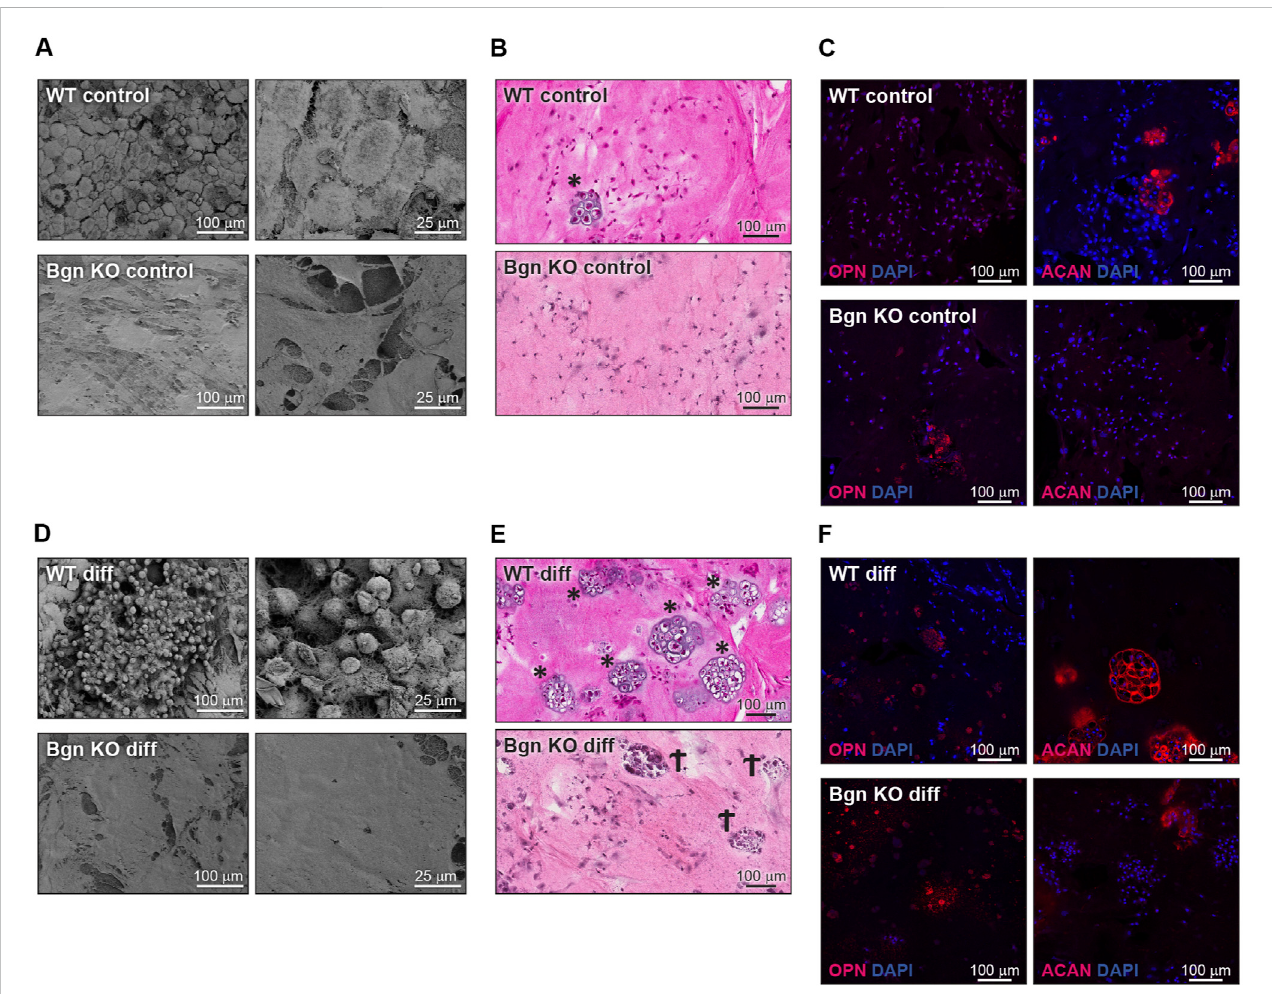
FIGURE 5 Bgn affects cartilage and bone differentiation in 3D culture system. (A) SEM images of the ECM secreted by undifferentiated (control) PDCs in the 3D structures, representative images ( n = 5 per group). (B) H&E staining of the control 3D structures representative images ( n = 5 per group). * marks chondrocytes. (C) Immunostaining ofthecontrol 3Dstructures stained for ACANandOPN, representativeimages. Seealso Figure S5A-C ( n = 5-8pergroup). (D) SEM images of the ECM secreted by the differentiated PDCs in the 3D structure, representative images ( n = 5 per group). (E) H&E staining of the differentiated 3D structures, representative images ( n = 5 per group). * marks chondrocytes. Ϯ marks dead cells. (F) Immunostaining of the differentiated 3D structures stained for ACAN and OPN, representative images. See also Supplementary Figures S5A – C ( n = 5-8 per